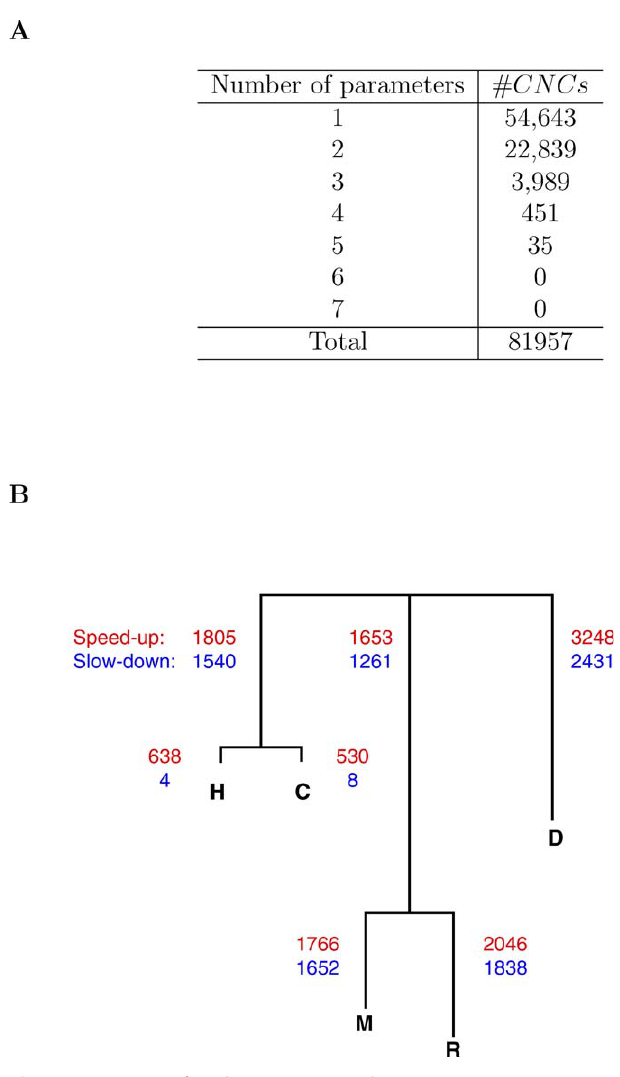
Figure 6. Patterns of Evolution in Mammalian CNCs (A) Classification of evolutionary patterns in mammalian CNCs according to our modified AIC. The left-hand column indicates the number of model parameters, where ‘‘ 1 ’’ indicates that there is a single substitution rate on the entire tree, and where ‘‘ 7 ’’ indicates a separate rate on every branch. (B) The tree shows how many of the CNCs that are best fit by the two- parameter model have altered rates on each branch. Rate increases are printed in red (upper text) and rate decreases in blue (lower text). The classification of the remaining 2,419 CNCs with two rate parameters that fall into our compound models is summarized in Table S12.